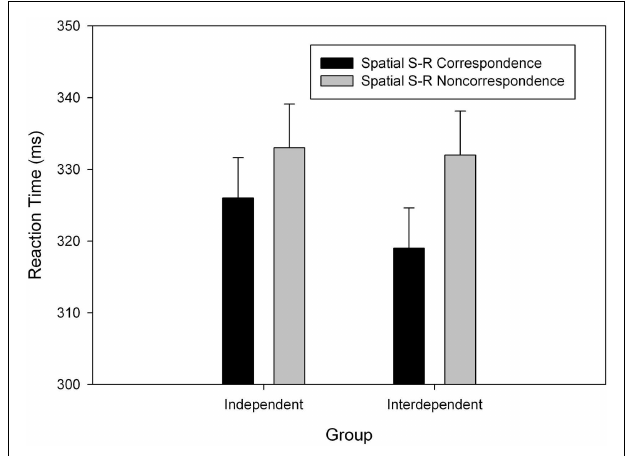
FIGURE 2 | Mean reaction time as a function of group (Independent vs. Interdependent) and spatial stimulus-response (S-R) correspondence. Error bars show standard errors of the